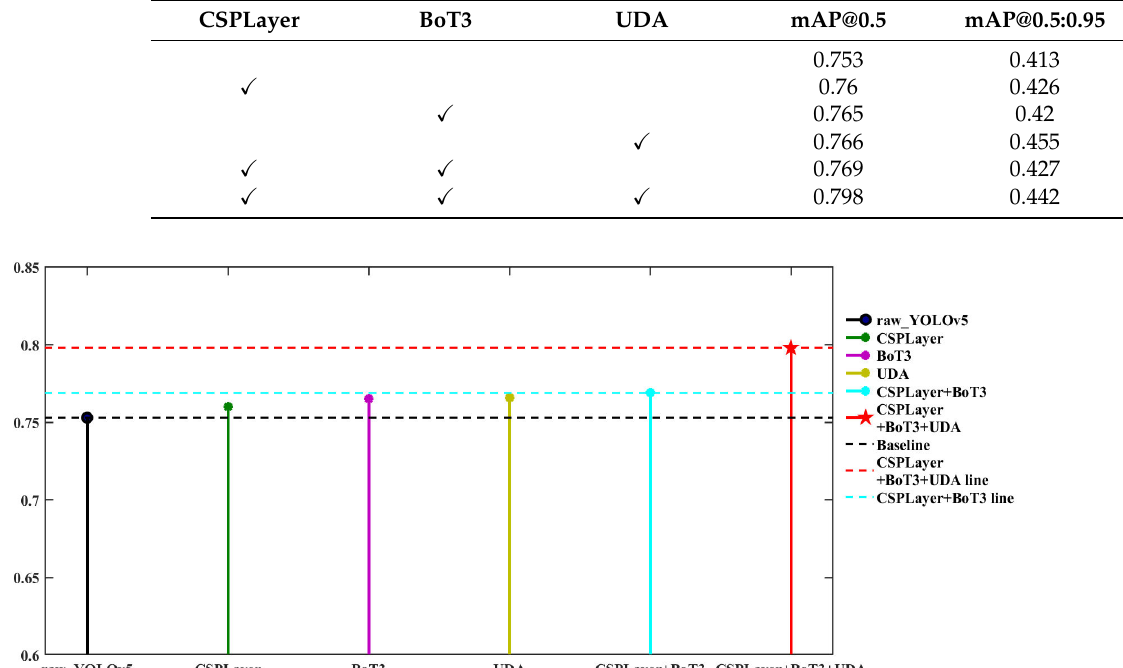
Figure 17. Visualization of results of ablation experiments on URPC 2019.